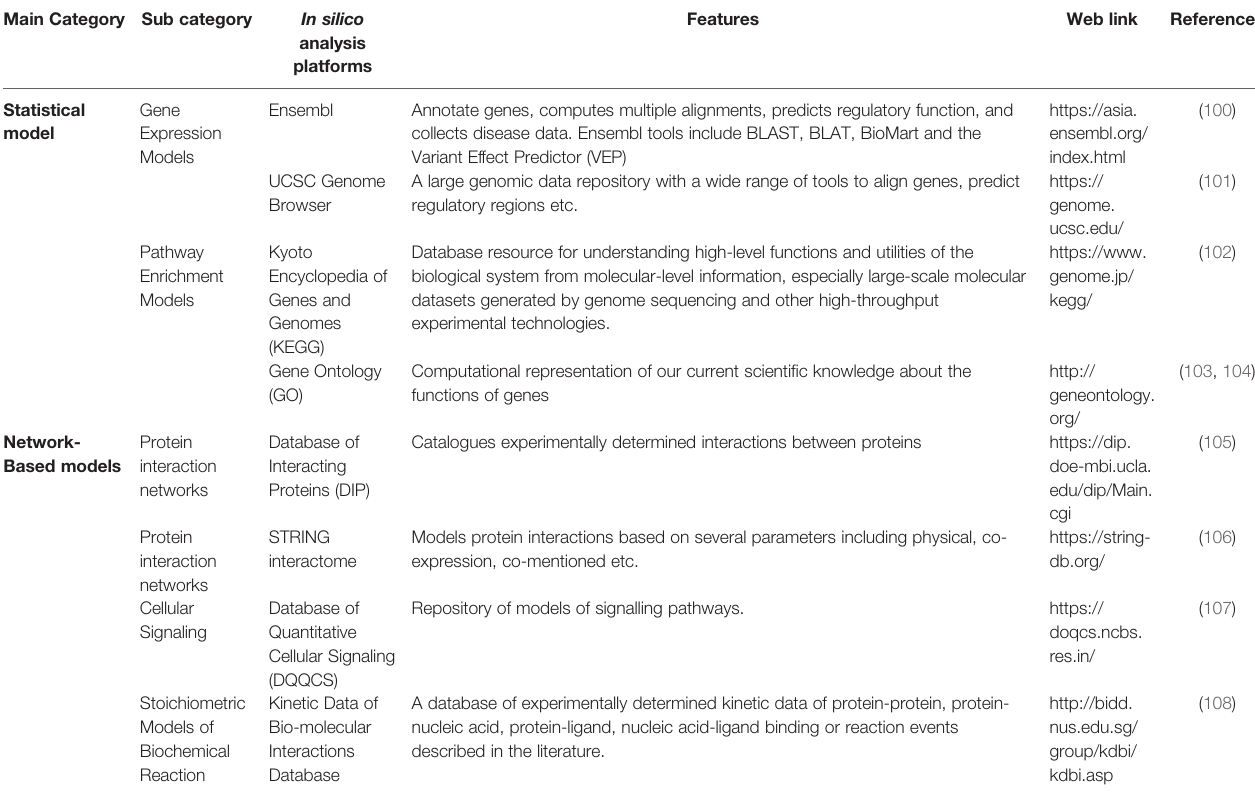
TABLE 2 | Web-based resources of in silico platforms for modelling